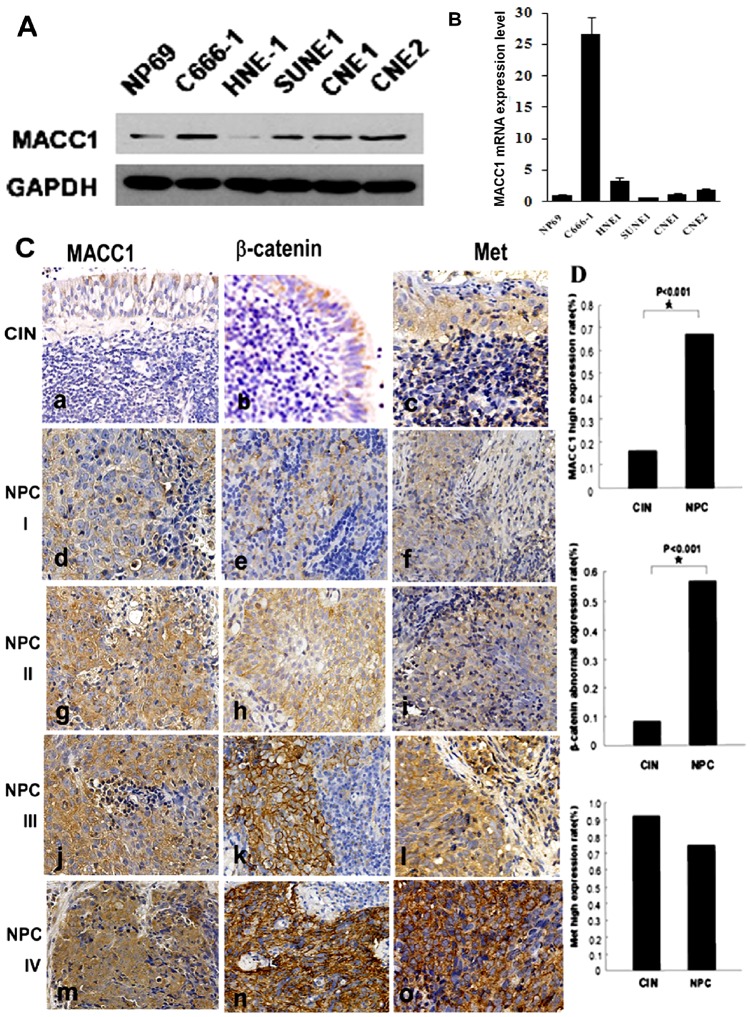
MACC1 protein expression in NPC cell lines (C666-1, HNE1, SUNE-1, CNE1 and CNE2) and normal nasopharyngeal cell (NP69) by western blot analysis(A); MACC1 mRNA expression in NPC cell lines and normal nasopharyngeal cell (NP69) by real-time PCR analysis (B); MACC1, β-catenin and Met expression in NPC and chronic inflammation of the nasopharynx (CIN) tissues by immunohistochemistry staining(C-D).AEG-1, β-catenin and Met expression was shown in CIN (a, b, c) and NPC with clinical stage I (d, e, f), II (g, h, i), III (j, k, l), and IV(m, n, o). Immunohistochemistry staining ×200(C); MACC1 and β-catenin expression was higher in NPC than that in chronic inflammation of the nasopharynx, respectively *p<0.001. There was no significant difference between Met expression in NPC and chronic inflammation of the nasopharynx (D).